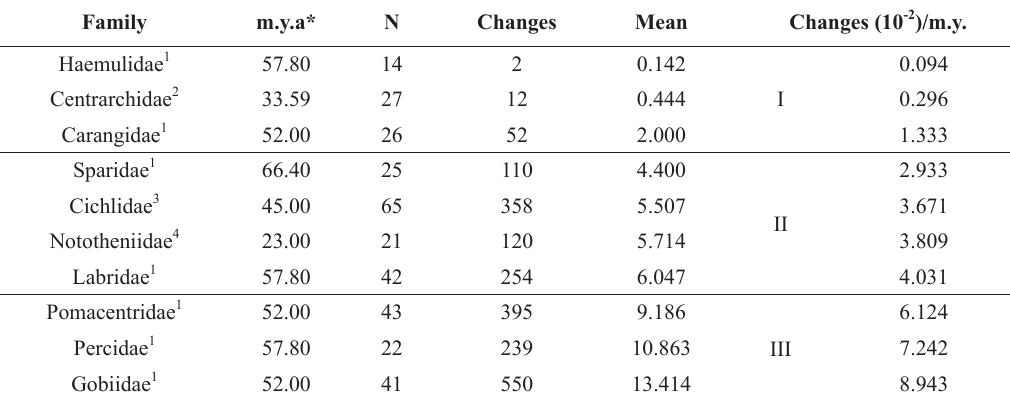
Rates of chromosomal changes per million years in some families of Perciformes (I, low; II, intermediate; and III,